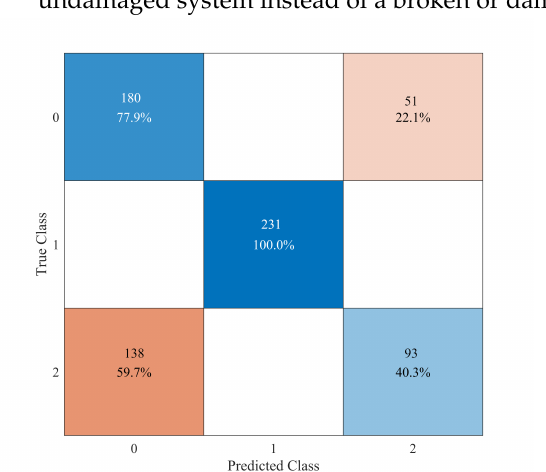
Figure 11. Confusion matrix for the 3-class recognition problem regarding the undamaged system (class “0”) and the failures of element “Elm 4115” (class “1” and “2”).